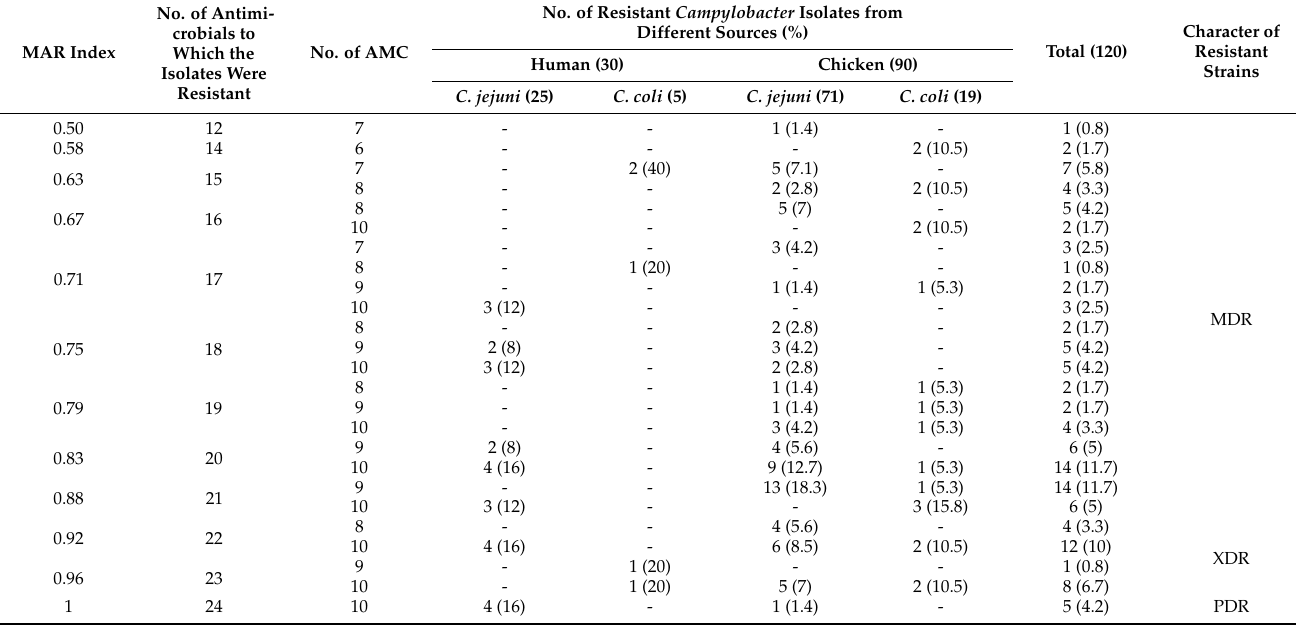
Table 3. Multiple antibiotic resistance indices of Campylobacter species isolated from different sources.